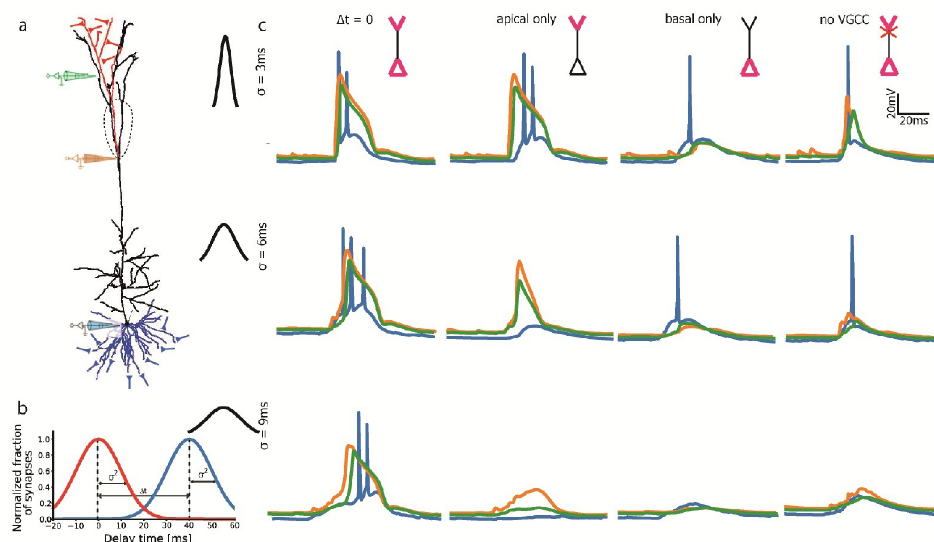
Fig 1. Burst initiation by basal and tuft input distributed in time. a. Model L5PC, schematically showing 50 basal (blue) and 30 apical tuft (red) excitatory synaptic locations (drawn from uniform distribution over the appropriate colored region). Electrodes are shown for corresponding voltage traces in c . b. Temporal distribution of input. Activation time is drawn from two tree-specific (same colors as a ) normal distributions with equal variance and mean (unless noted otherwise). c. Voltage traces showing outcome of input to basal/tuft/both trees, with three σ values and no-VGCC control. Coincidental input to both trees results in burst firing for all σ ’s. Tuft activation alone creates a burst for small σ , a dendritic spike for intermediate and nothing for high (equivalent to a lower synapse number). Basal activation results in a single AP at most, and removing VGCC returns all to one